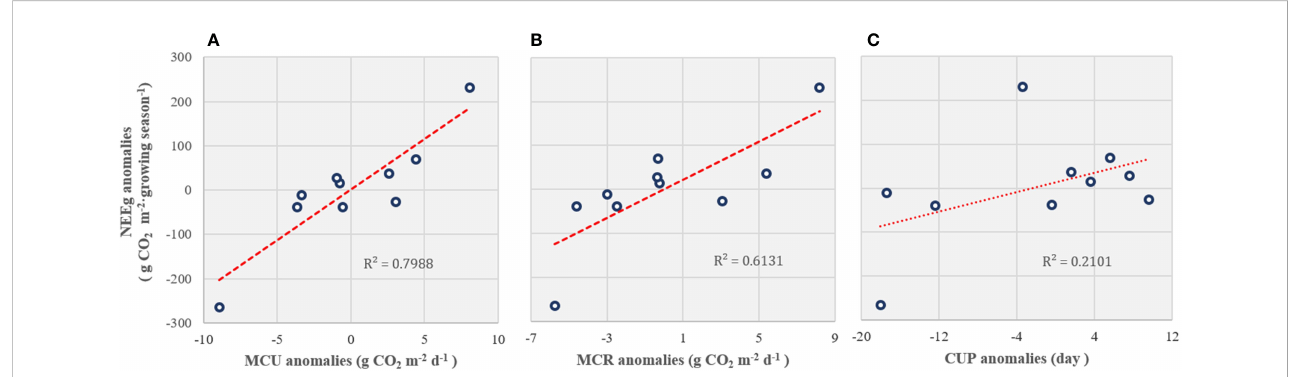
FIGURE 4 The relationship between the carbon fl ux (NEE g ) anomalies during the growing season and (A) the maximum CO 2 uptake rate (MCU), (B) maximum CO 2 release rate (MCR), and (C) carbon uptake period (CUP) anomalies.